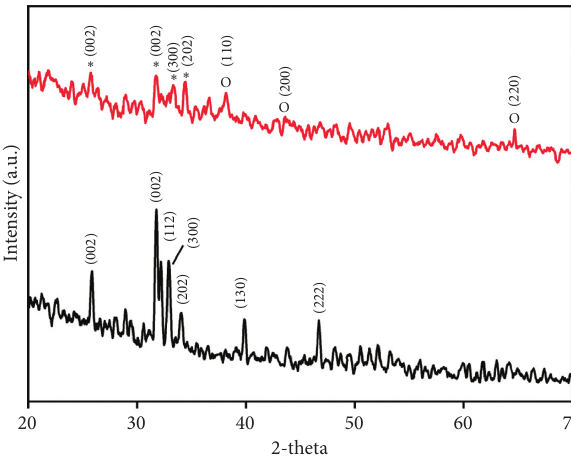
Figure 10: X-ray patterns of (A) HAp and (B) HAp@Ag nanocomposite.